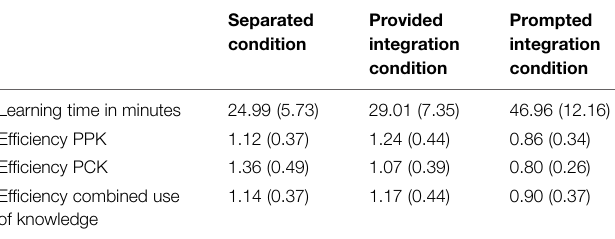
TABLE 6 | Mean (and SD) of learning time and efficiencies in the three experimental